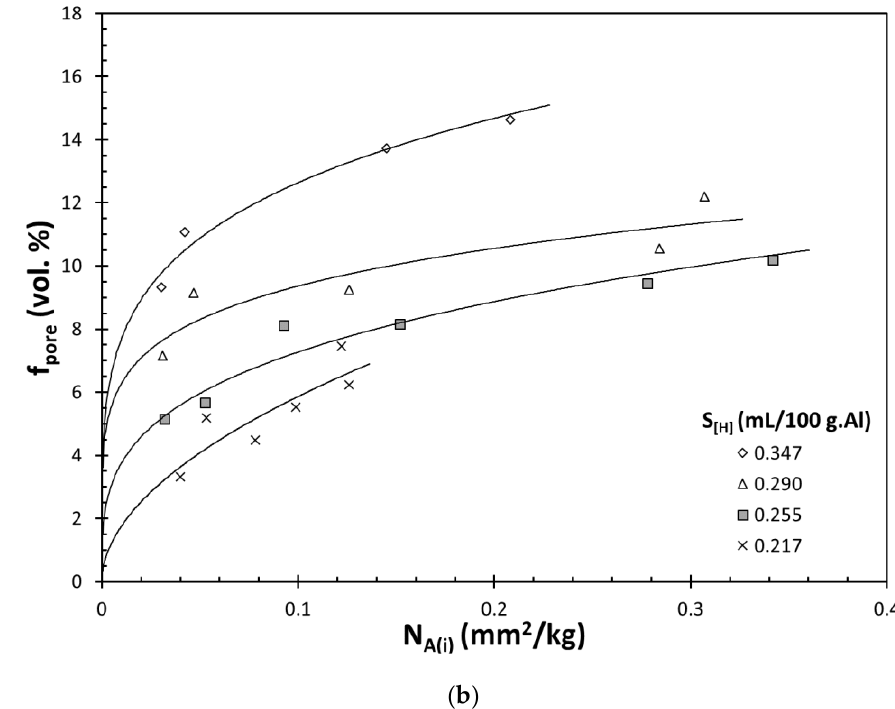
Figure 8. The change in ( a ) pore number density and ( b ) pore volume percent with number density of entrainment defects and hydrogen content in the melt in A356 aluminum alloy castings (data are from Ref. [74]).